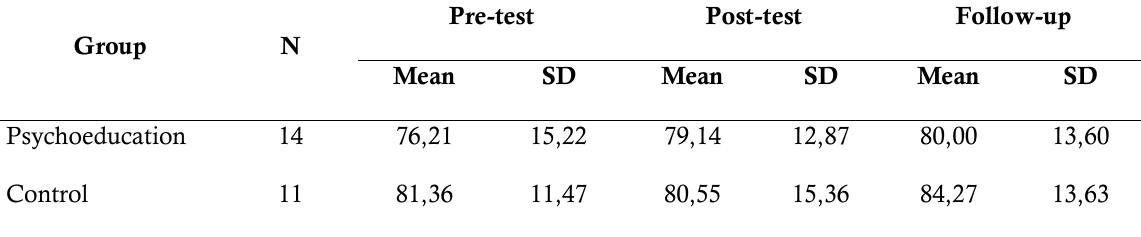
Table 2. Description of Score of Parenting Stress Pre-test Post-test Follow-up Group N Mean SD